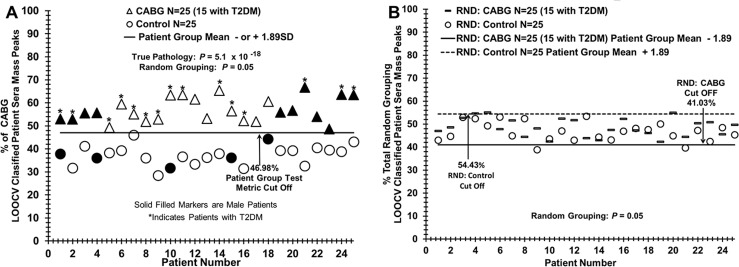
Distinguishing sera from CABG patients versus control individuals using LOOCV mass peak and sample randomization analyses.(A) Serum discrimination of CAD patients before CABG procedure (triangles) from control individuals (circles) by % of LOOCV CABG classified mass peaks. A cut off value is present (- or + SDs [standard deviations] from the CABG or control groups respectively) to determine test metric values (e.g. true positives). Patients with an “*” represent those with T2DM; darkened symbols indicate male subjects. (B) Non-serum sample discrimination when the two different sample groups from (A) are mixed together randomly followed by the same LOOCV mass peak analysis.